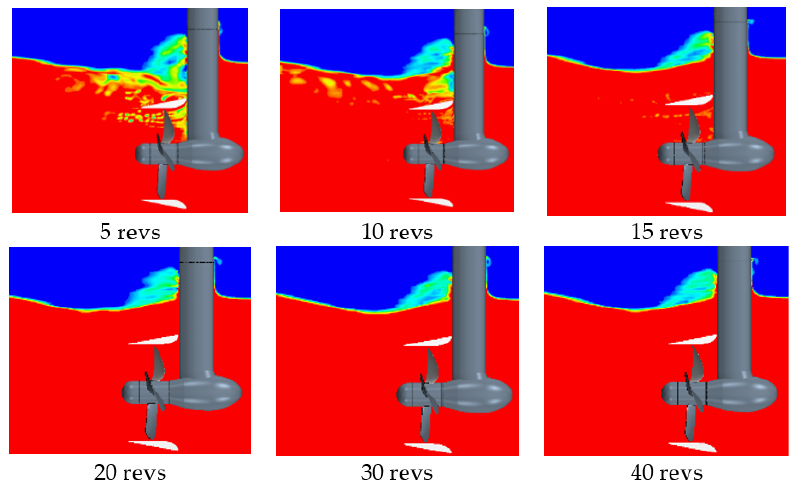
Figure 18. Contours of volume fraction at different solution time instances for propulsor submergence H/Dp = 1.0, at J =